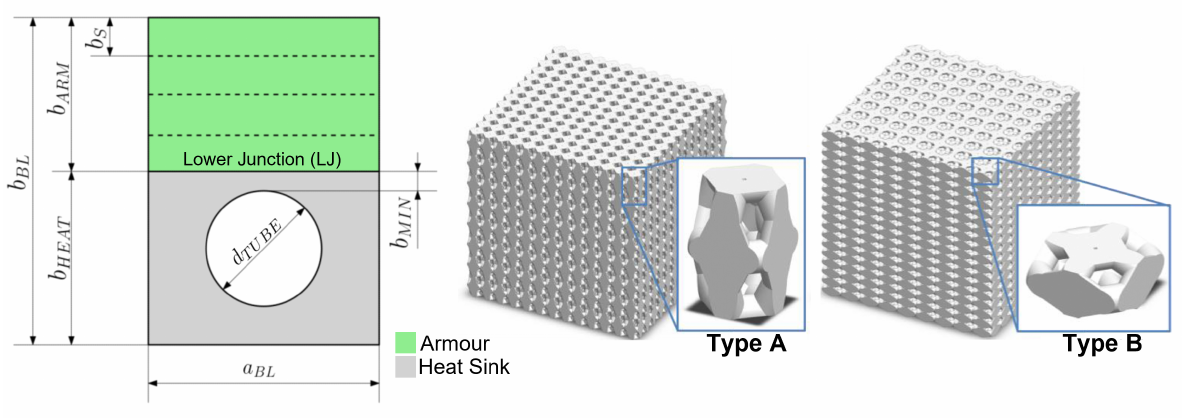
Figure 2. Two-dimensional model of the flat tail component subjected to parametric optimisation analysis and the CAD models of Type A and B elementary cells.